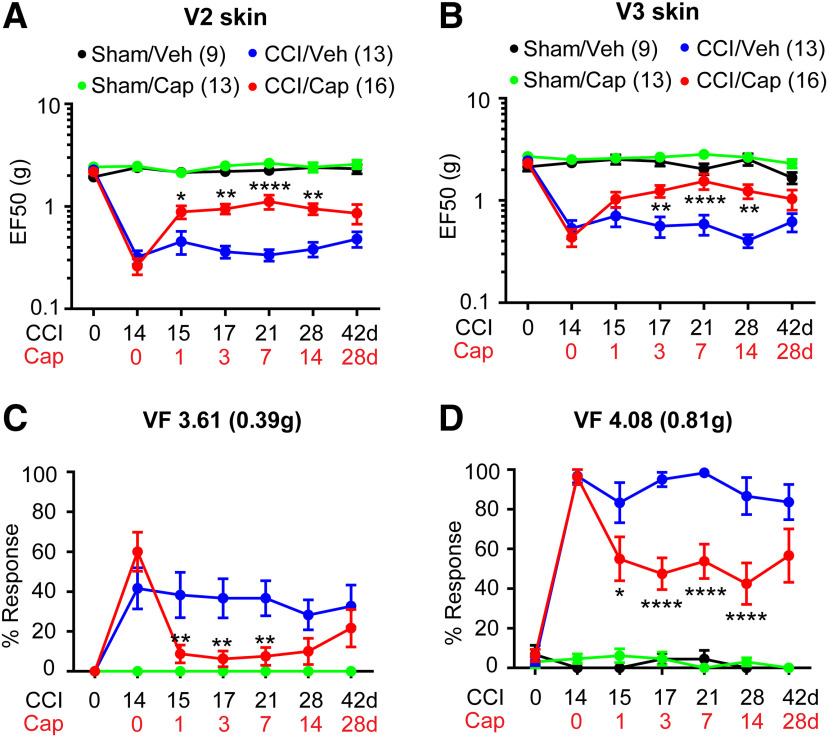
Single subcutaneous injection of capsaicin attenuates mechanical hyperalgesia in mice with ION-CCI. A, B, Mechanical sensitivity in the ipsilateral V2 skin (A) or in the ipsilateral V3 skin (B). Vehicle or capsaicin (10 µg) was subcutaneously injected into the ipsilateral V2 skin area 14 d after CCI or sham surgery. C, D, Percent response frequency in response to VF hair 3.61 (C) or 4.08 (D). Symbols and n numbers within parenthesis in A, B are also applied to C, D. Two-way ANOVA followed by Bonferroni post hoc test (CCI/Veh vs CCI/Cap); *p < 0.05, **p < 0.01, ****p < 0.0001.